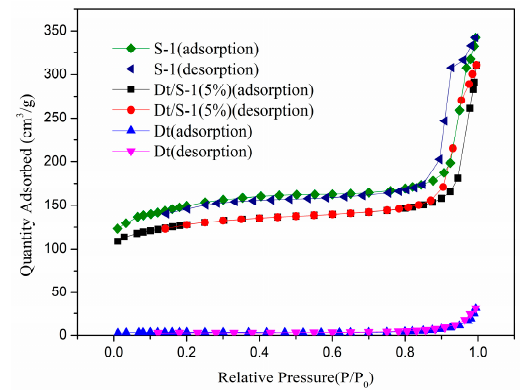
Figure 3. N 2 adsorption–desorption isotherms of Dt, S-1 and Dt/S-1 (5 wt%).